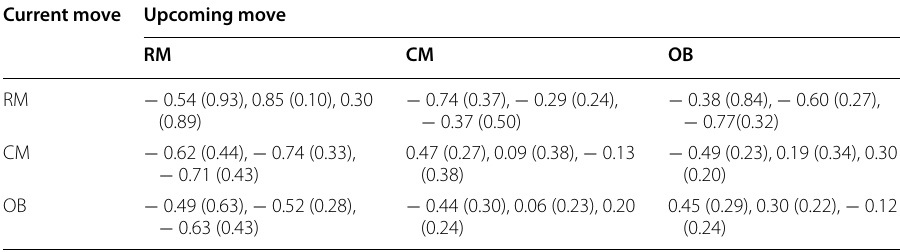
The values are shown as Mean (SD)